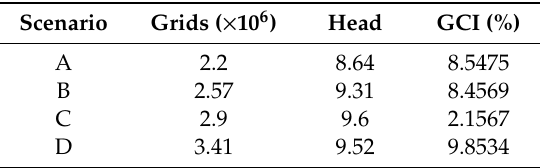
Table 3. Four di ff erent scenarios for analyzing the Grid Convergence Index (GCI).